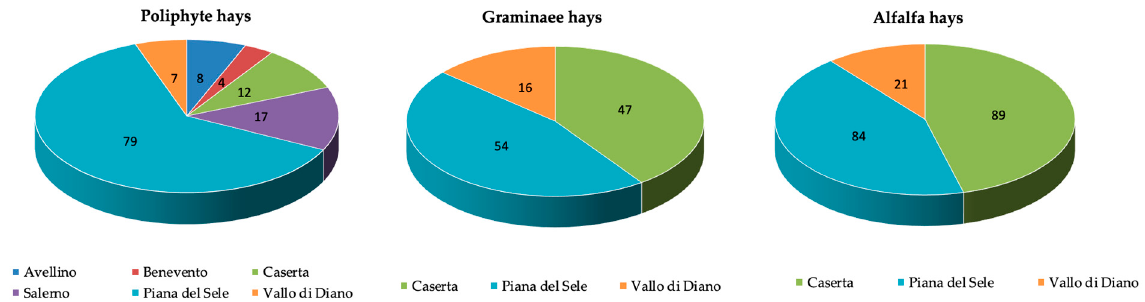
Figure 2. Classification of the hays according to the experimental area.